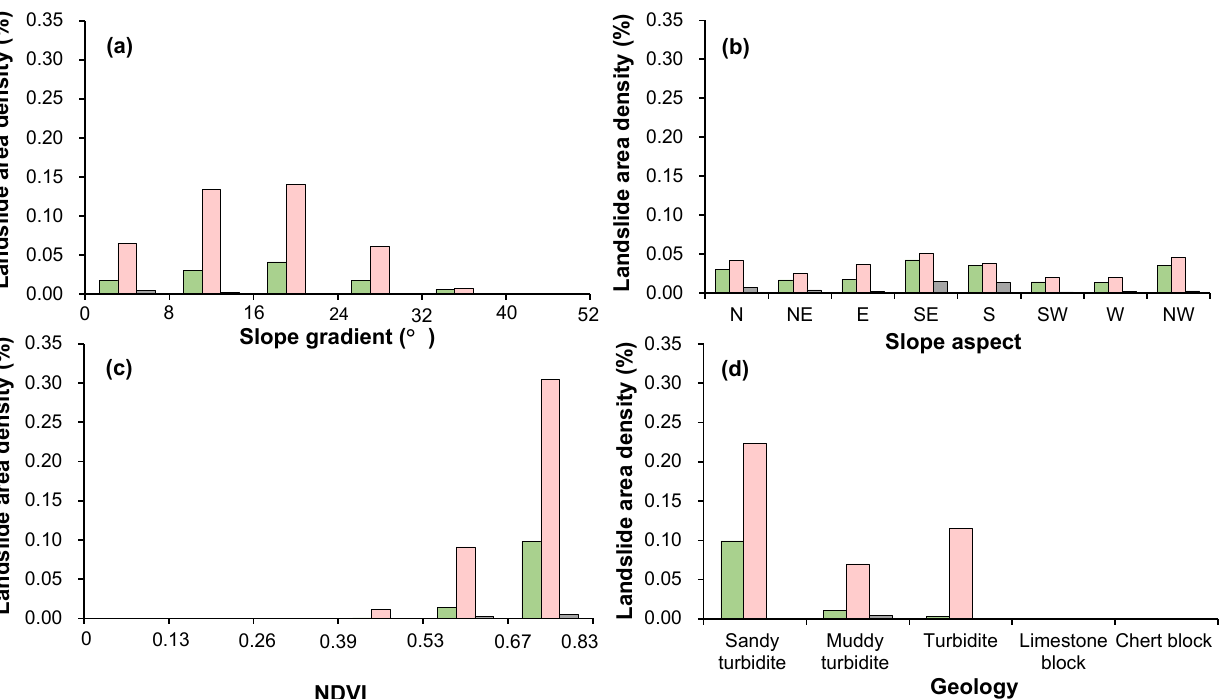
Figure 6. Landslide area density of “forest” (green), “citrus grove” (pink), and “the others (gray)” for each category of conditioning factors: ( a ) slope gradient; ( b ) slope aspect; ( c ) normalized difference vegetation index, and ( d ) geology.